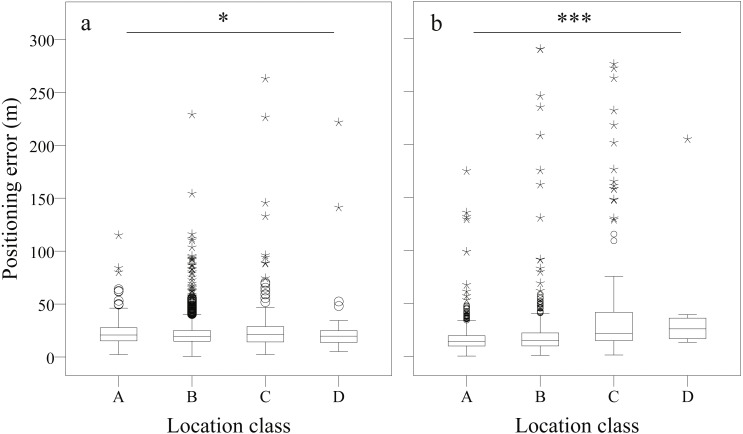
Boxplots showing the differences among positioning errors by Location Class at DZ (A) and TC (B).The open dots indicate mild outliers (Q3 + 1 IQR ∼ Q3 + 3 IQR), and the stars indicate extreme outliers (>Q3 + 3 IQR). Extreme Outliers with positioning error >300 m were not showed. * P < 0.05, *** P < 0.001. Significance levels were based on Kruskal Wallis test.